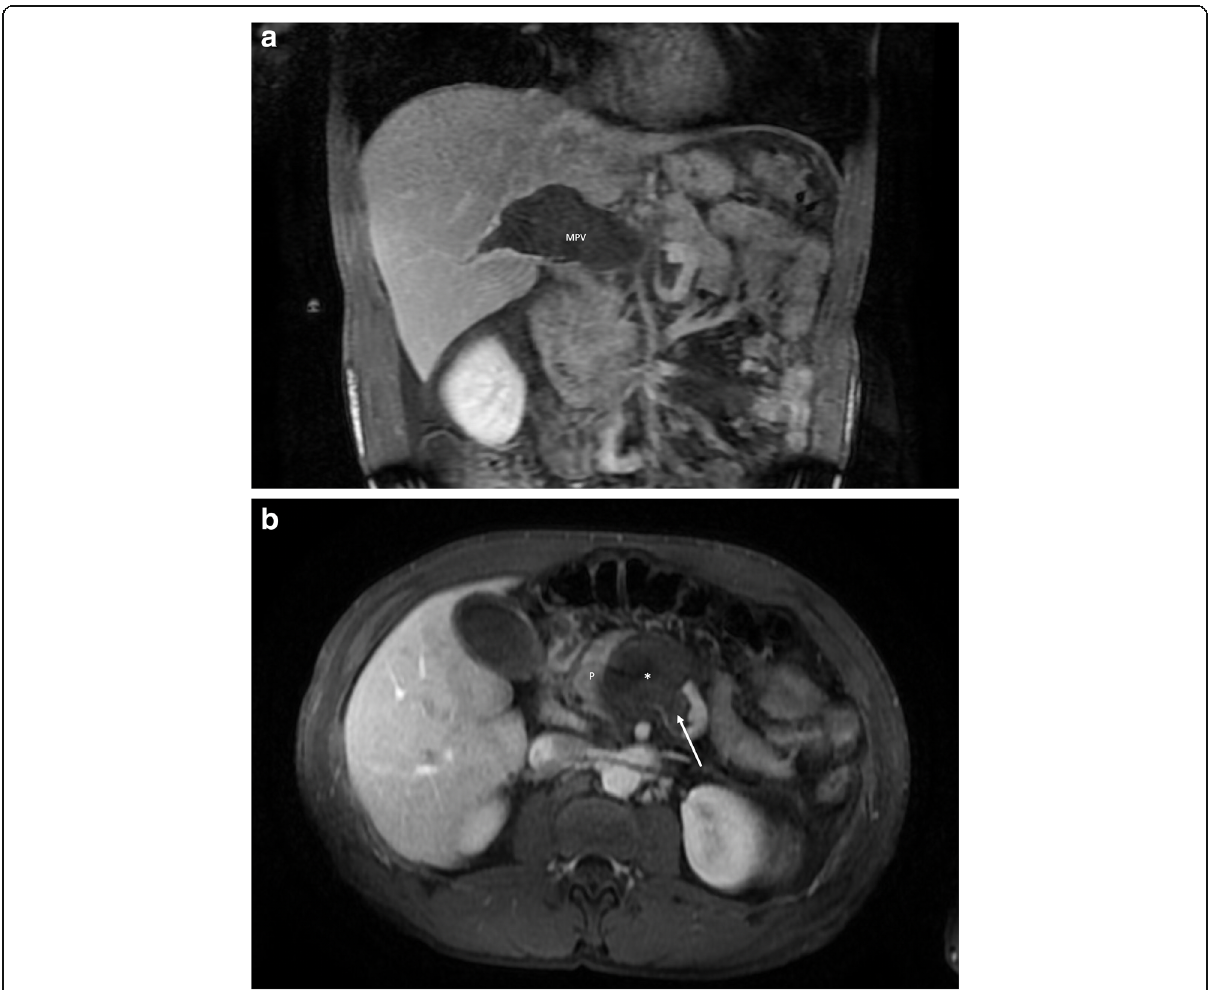
Fig. 1 A Coronal contrast-enhanced T1 fat-saturated MRI image demonstrates the thrombosed extrahepatic portal venous component (MPV) of the large portomesenteric aneurysm. Thrombus also extends into the right portal vein. B Axial contrast-enhanced T1 fat-saturated MRI image demonstrates occlusive thrombus at the aneurysmal portosplenic confluence (*) abutting the adjacent pancreas (P). Non-occlusive thrombus is present in the central aspect of the splenic vein